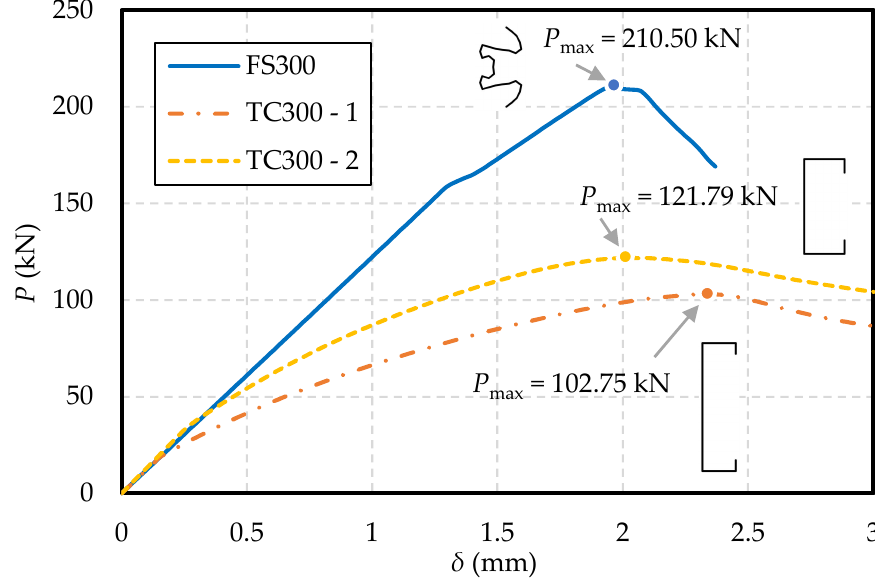
Figure 16. FS300 FE results.